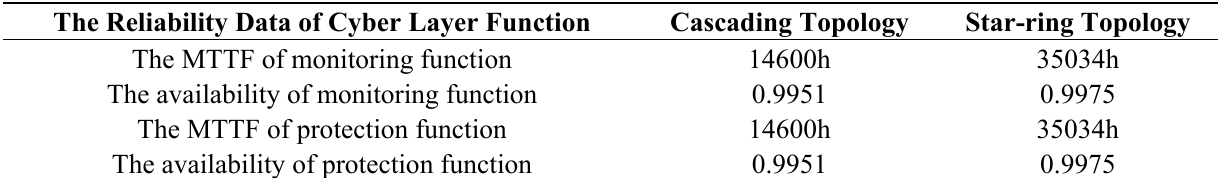
Table 2. The MTTF and availability of the cyber layer functions.